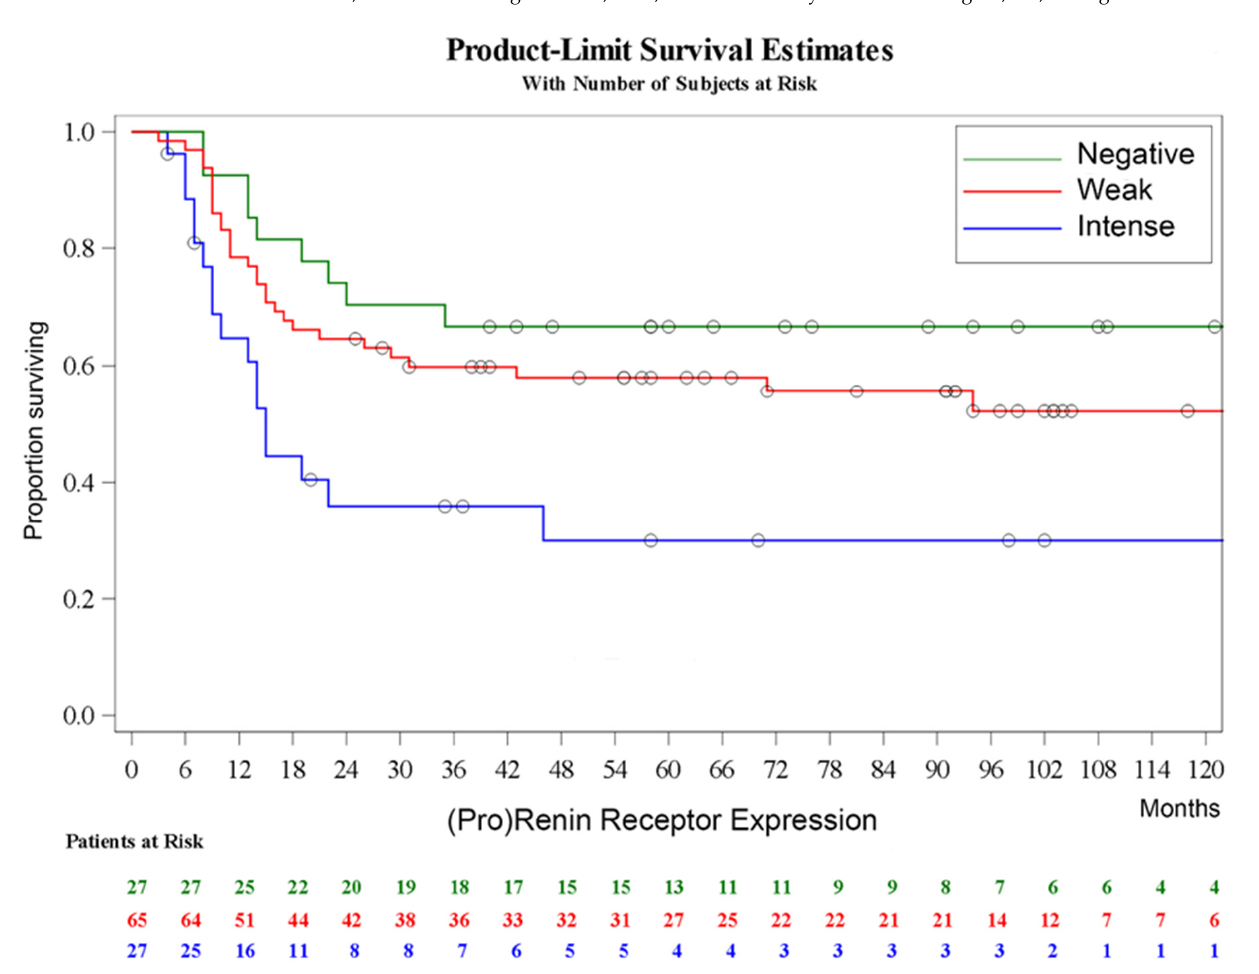
Figure 2. Kaplan–Meier curve of disease-specific survival according to the immunohistochemical expression of prorenin receptor (absent, weak, and intense) in patients with urinary bladder cancer treated by cystectomy; log-rank, p = 0.008. Table 4. Cox regression model for cancer-specific survival prediction stepwise model with p = 0.1 in this series; statistically significant values highlighted in bold.